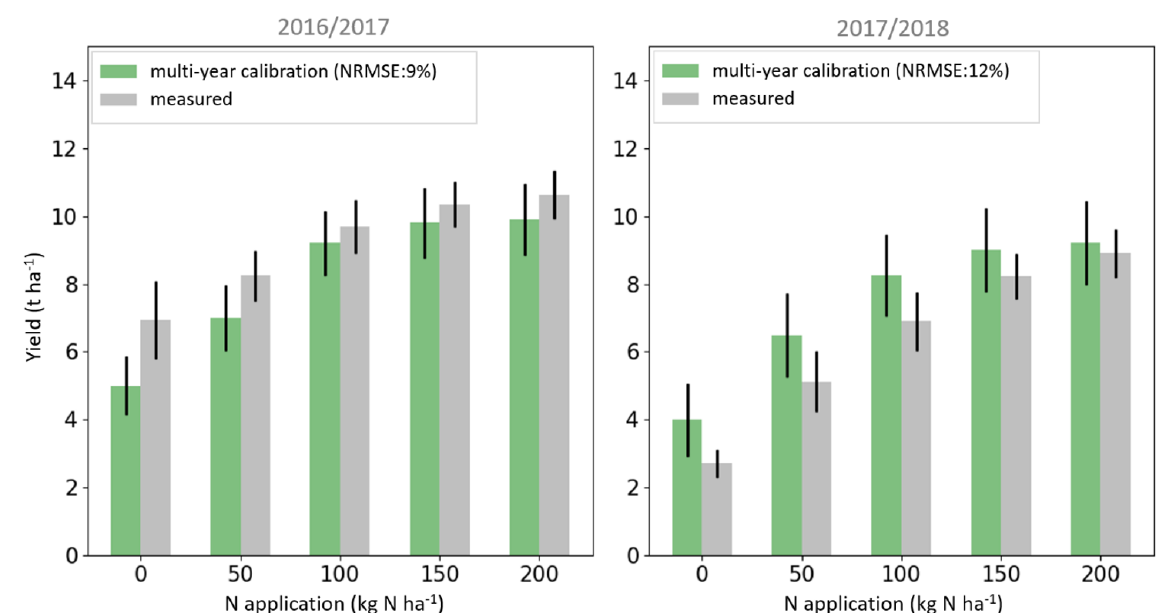
Figure 5. Bar plots of the DALEC-Crop ensemble mean yield estimates for the validation trial plots derived from the multi-year model calibrations (green) compared to the observations (grey) covering the range of N treatments for the 2016–2017 and 2017–2018 growing seasons. Error bars represent the standard deviation of the distribution of modelled yield estimates and measurements.